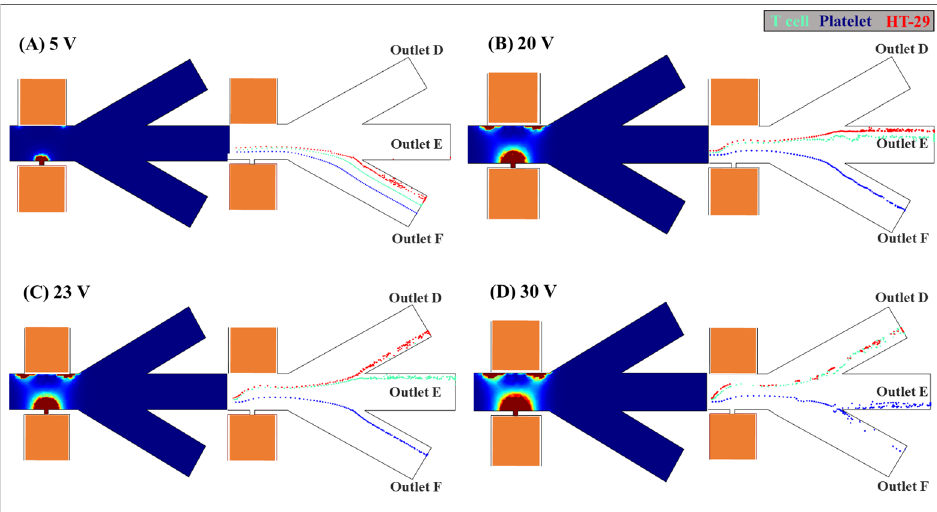
Figure 7. Numerical simulations of the distribution of the electric field gradient ( ∇|𝐸| 2 ) and the effect of the applied electric field on the separation of the T cells, platelets, and HT-29 by the integrated MAP-DEP microchannel. The dependence of the cell trajectories on the applied voltage at the small orifice: ( A ) 5, ( B ) 20, ( C ) 23, and ( D ) 30 V. The large orifice is grounded. The frequency of the electric